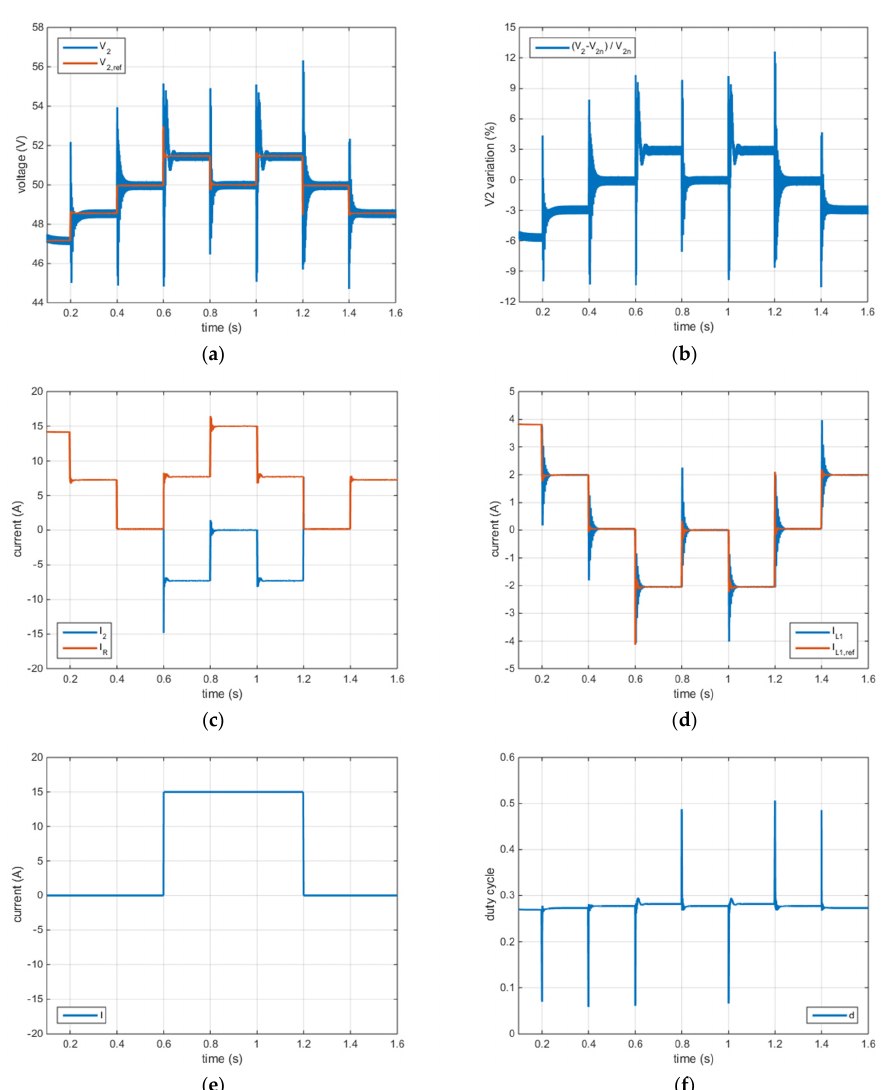
Figure 7. Simulation results in Scenario #2 (SD − GN): ( a ) actual and reference grid voltage; ( b ) grid voltage variation; ( c ) output and load currents; ( d ) input inductor current and its reference; ( e ) external generator’s current; ( f ) duty cycle.